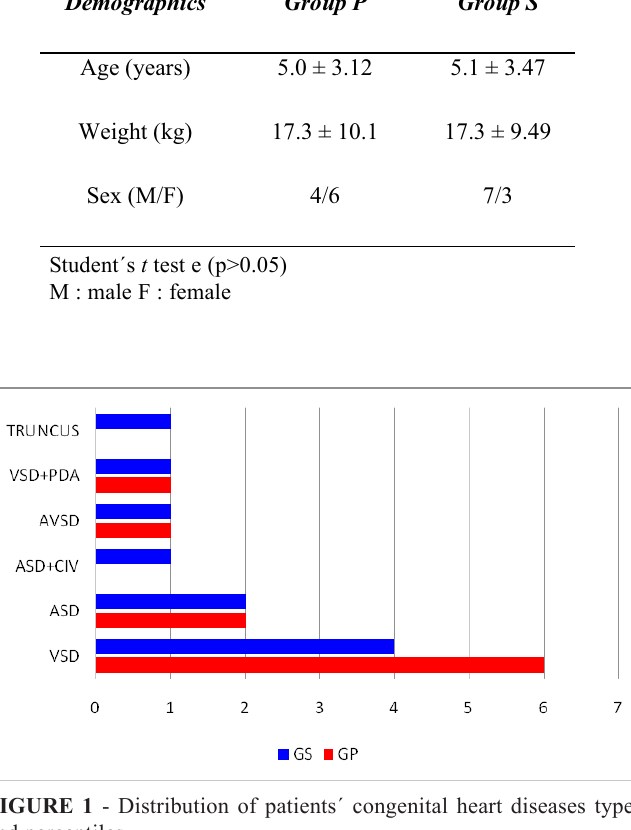
FIGURE 3 - GSH levels (micromoles per mililiter of fresh plasma) in children anesthetized with Propofol (GP) or Sevoflurane (GS). Bars represent mean±SD of GP (blue bars) and GS (red bars) groups at T0, after radial artery cannulation, T1, 30 minutes after cardiopulmonary bypass launch and T2, at the end of the surgical procedure. Values in T0, T1 and T2 timepoints are not significantly different in each group by Friedman´s test. GS is not different from GP group by